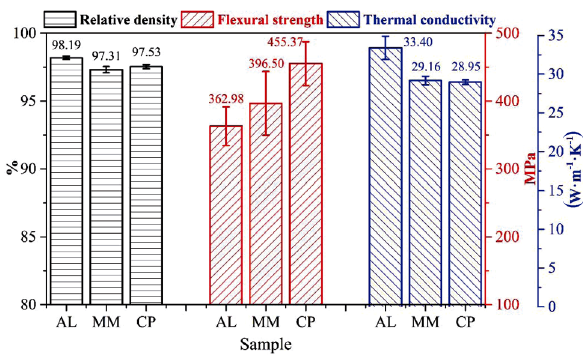
Fig. 10 Physical properties of the 3D printed Al 2 O 3